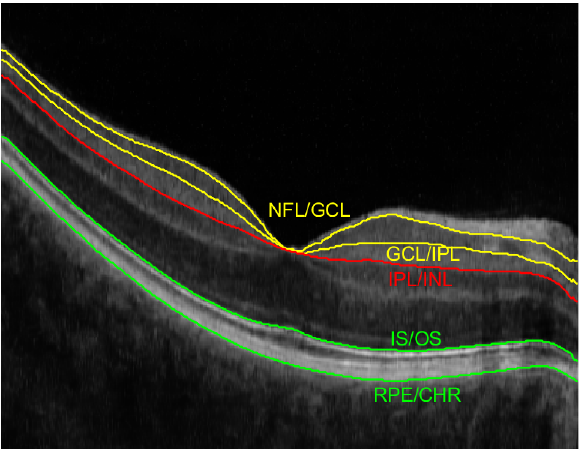
Figure 2. Example of OCT B-scan with annotated retina layers borders used for fundus reconstruction (NFL/GCL, GCL/IPL, IPL/INL, IS/OS, and